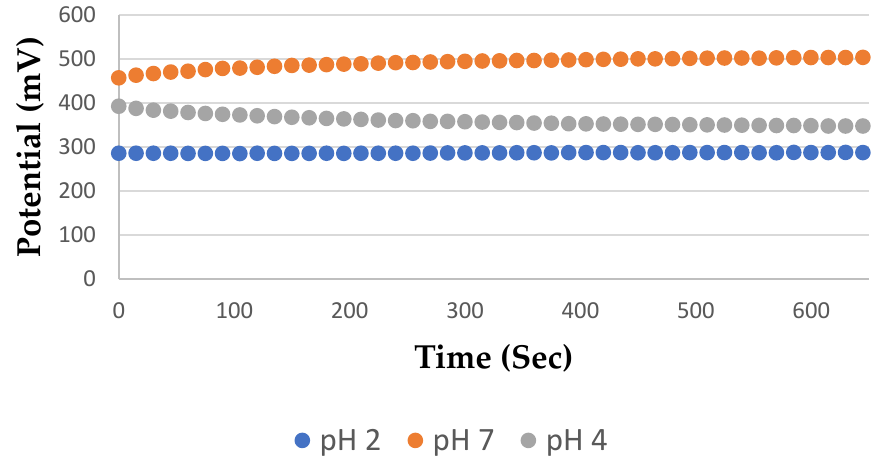
Figure 6. Graphical representation of potential difference vs. time for pH 2, 4 and 7.